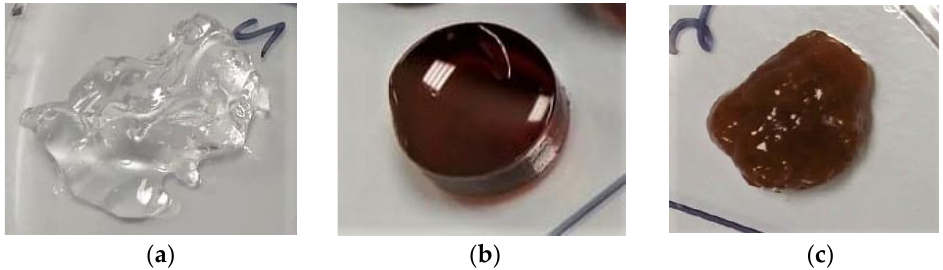
Figure 3. Photographs of the hydrogels: 1% alginate hydrogel ( a ); TA-AgNPs gel ( b ); and TA-AgNPs-containing alginate hydrogel ( c ).